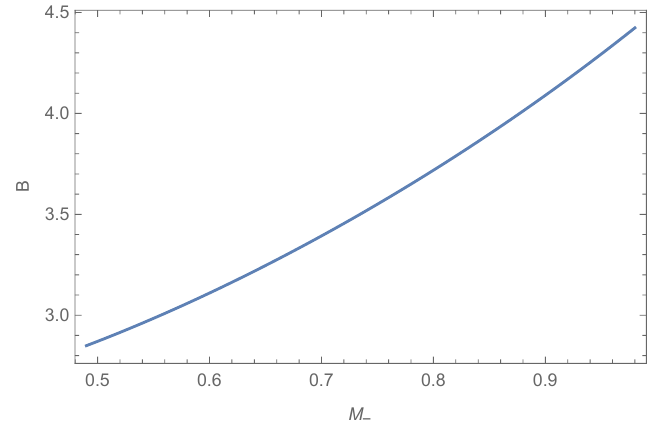
Figure 7 . The effective potential for the fixed initial RNAdS black hole mass. In this plot, G = 1 , L + = 1 . 335 , L − = 1 , σ = 1 , Q = 0 . 3 , and M + = 1 . The critial mass of the final RNAdS black 16 πG hole mass is M c = 0 . 4794 .